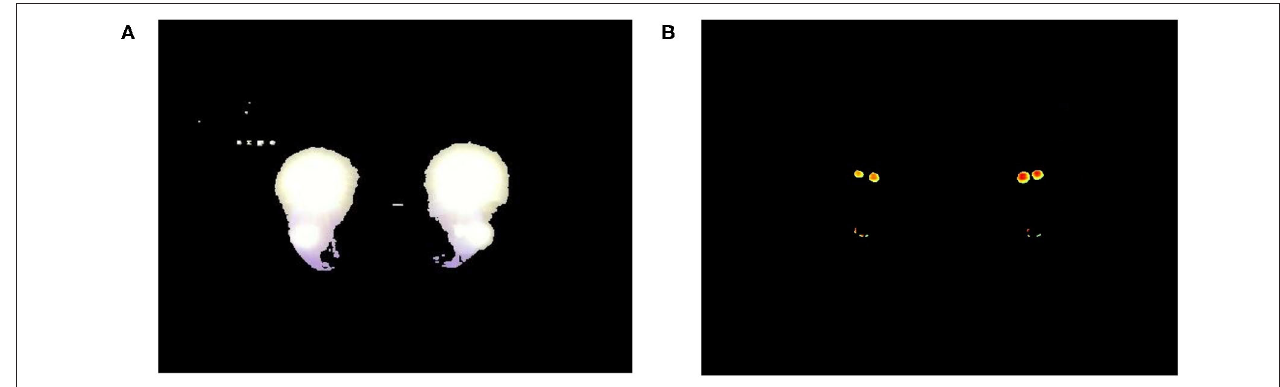
FIGURE 14 | Results of threshold processing. (A) A Red Green Blue (RGB) image after threshold processing. (B) A thermal image after threshold processing.